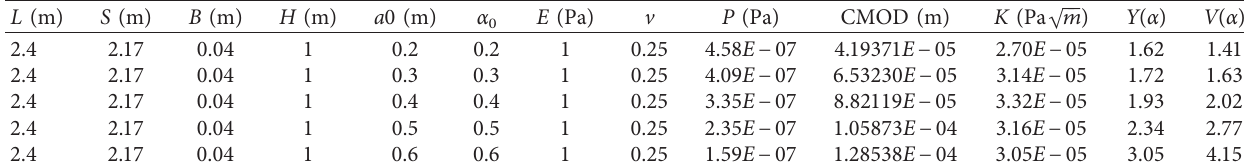
Table 1: Parameters for simulating three-point bending test of notched beam in Abaqus and results of simulation.